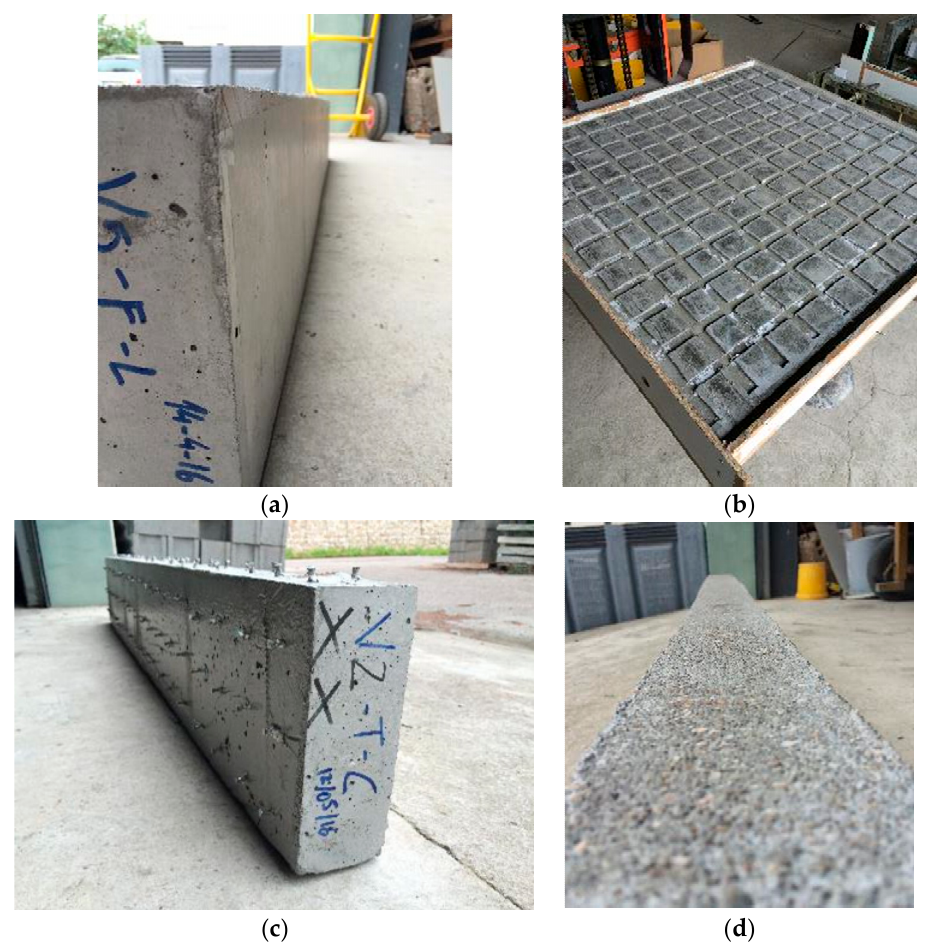
Figure 9. Different surface conditions for the interface between the cover and the bulk of RC members: ( a ) Smooth; ( b ) Indented; ( c ) Smooth with micro connectors; ( d ) treated with water jet.